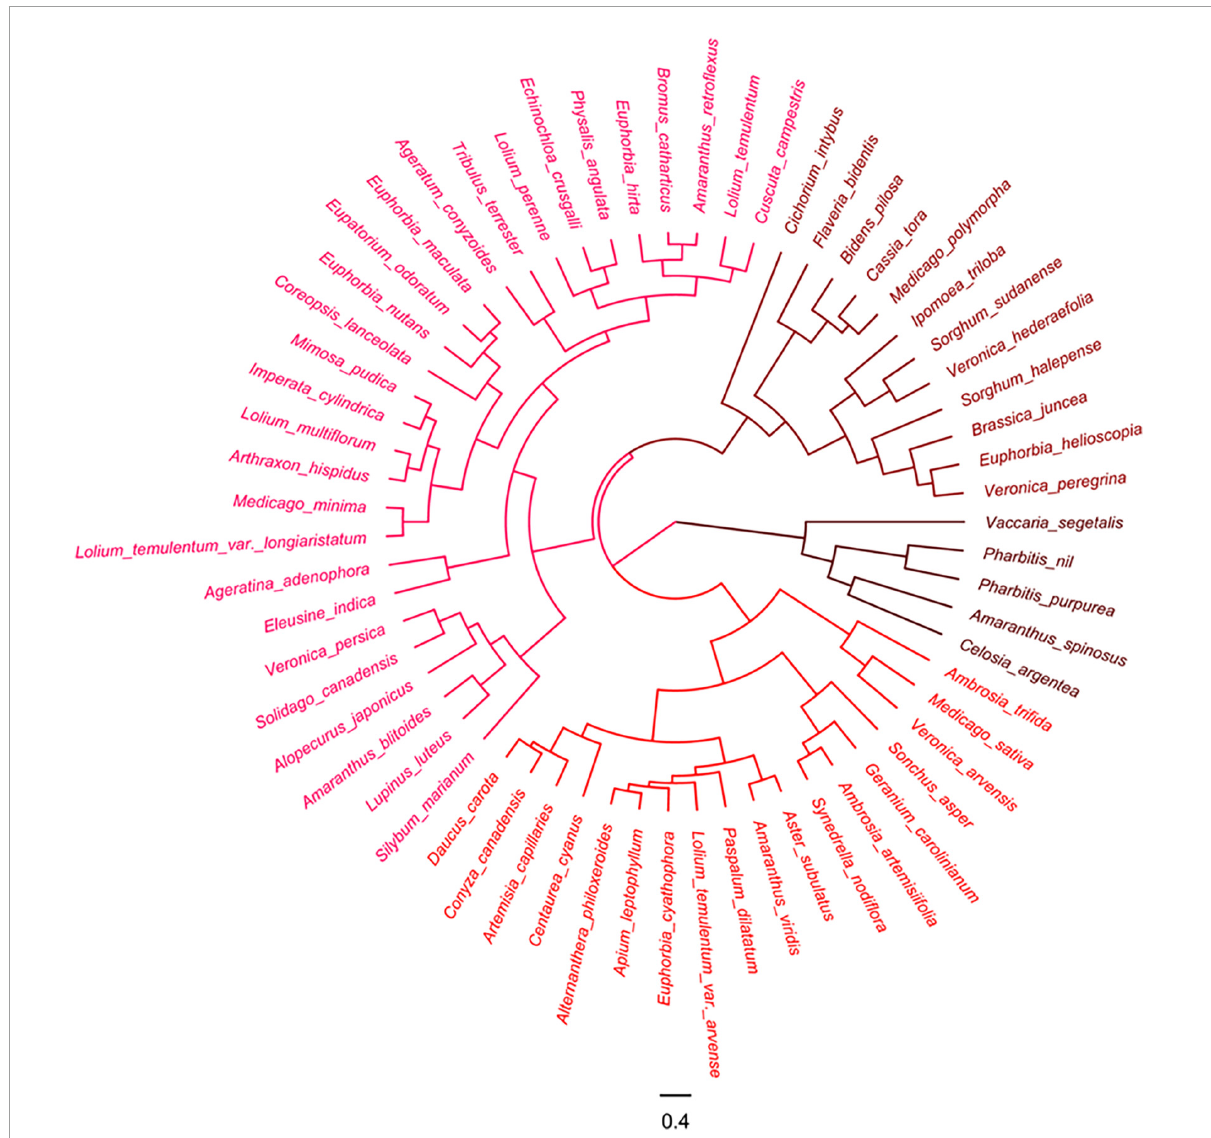
FIGURE5 Cluster analysis of woody plants based on color of pre- and post-stained seeds. Red color indicates visibility of stained seeds from visible to